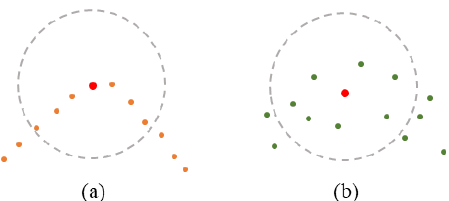
Figure 2. Illustration of the neighbourhood searching for local feature extraction. (a) Points at a building corner. (b) Points of vegetation. The local geometrical features (e.g., linearity, planarity, curvature, etc.) of these two situations are similar. Thus, they are difficult to distinguish with only the local geometrical features.